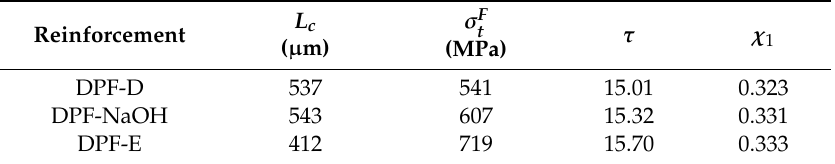
Table 3. Main results of the micromechanical